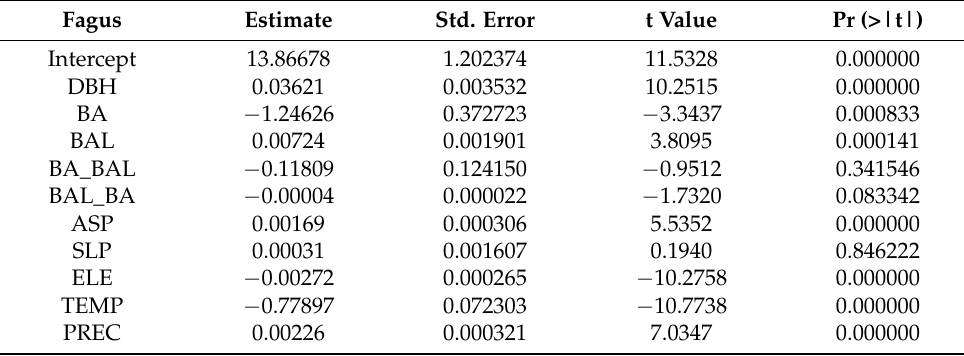
Table 1. Results of the linear mixed-effect model for Fagus diameter increment.